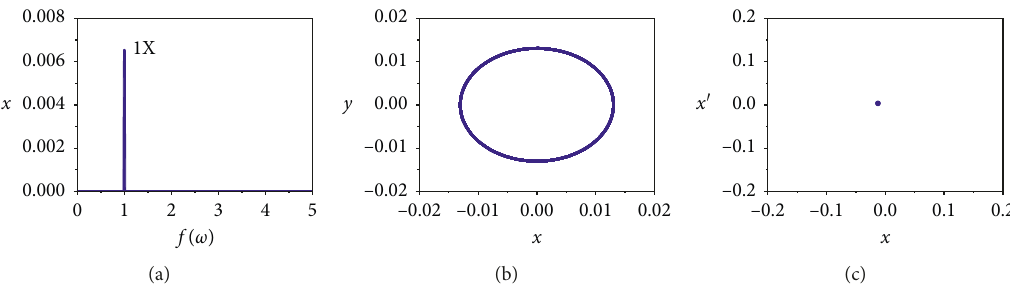
Figure 4: The periodic response of the rotor/seal system at s (c) The Poincar´e map of the x coordinate.